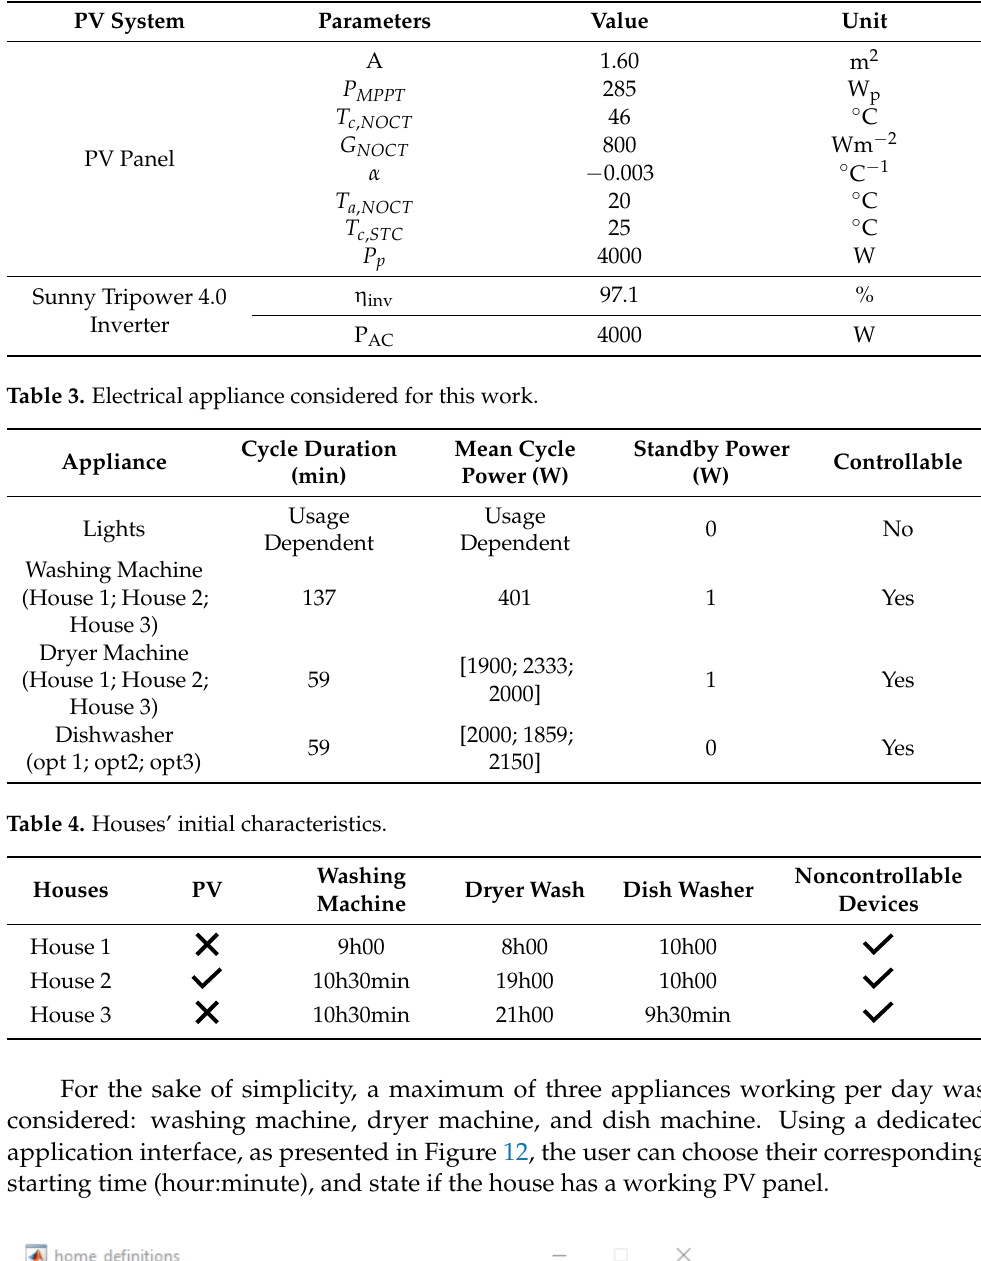
Table 6. Scenario summary.